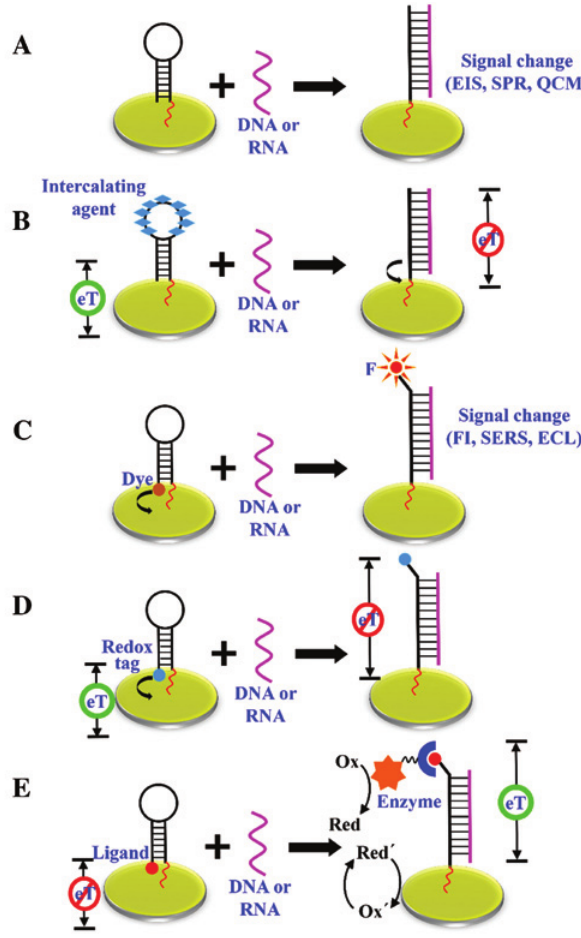
Figure 5: General principles for the determination of nucleic acids through HDP-based solid-phase biosensing platforms. (A) A label-free scheme, (B) an intercalating agent-based biosensor, (C and D) sensors with optically (C) or electrochemically (D) sensi- tive signaling tags, and (E) an enzyme-linked amplified detection strategy. ECL, electrochemiluminescence; eT, electron transfer; Fl, fluorescence intensity; QCM, quartz crystal